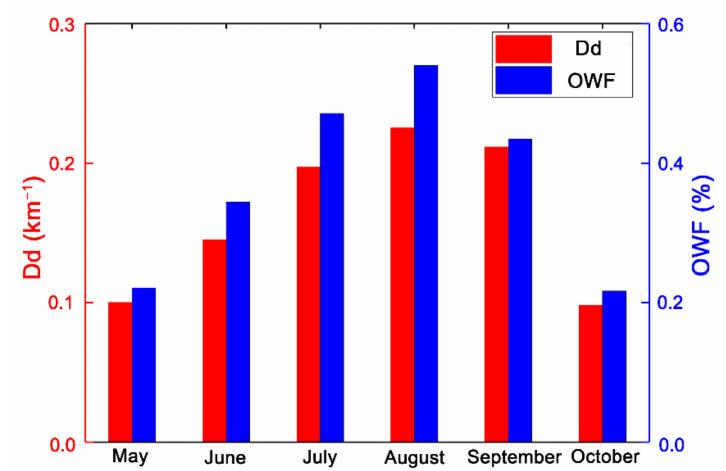
Figure 17. Monthly averages of OWF and Dd from 2017 to